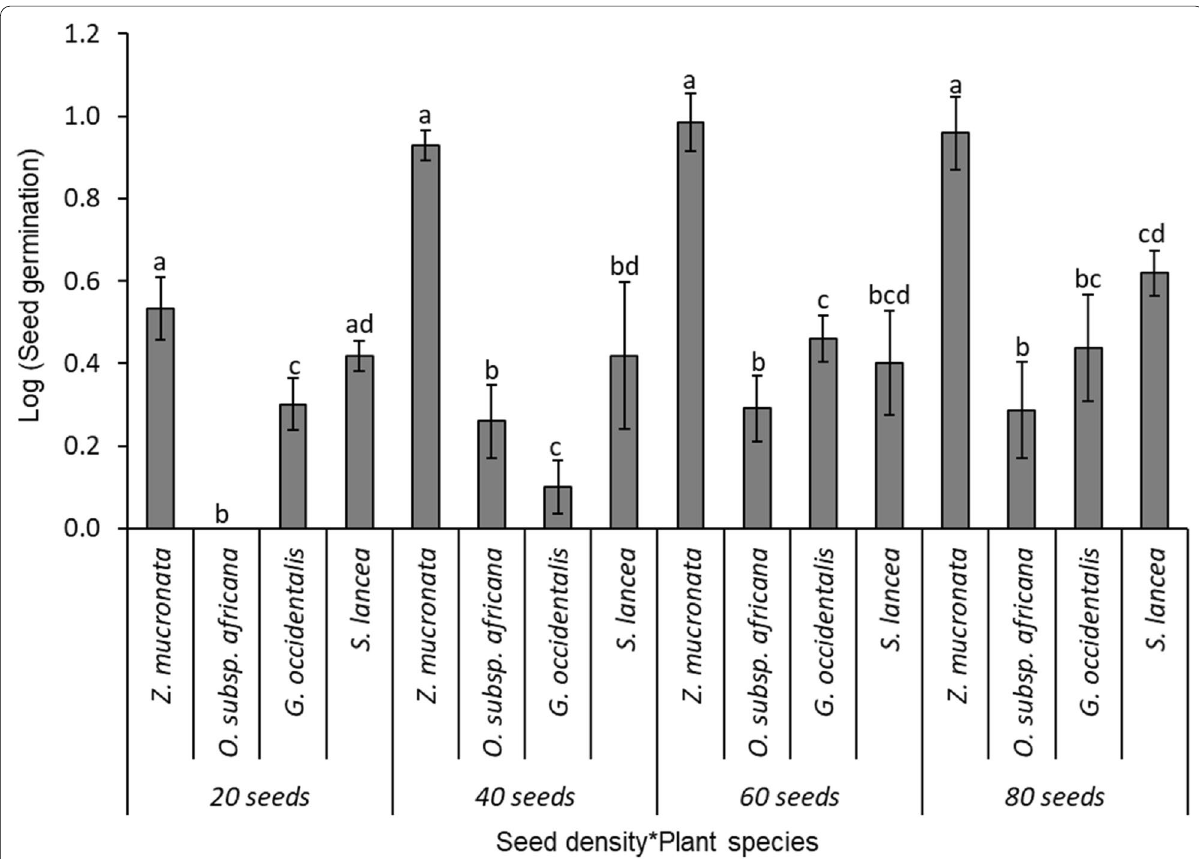
Fig. 6 Mean seed germination for different plant species in competition level 3 between four tree/shrub species: Z. mucronate , O. subsp. africana, G. accidentalis and S. lancea. The error bars represent the standard error of sample mean, and different letters above standard error bar denote significant differences between seed density